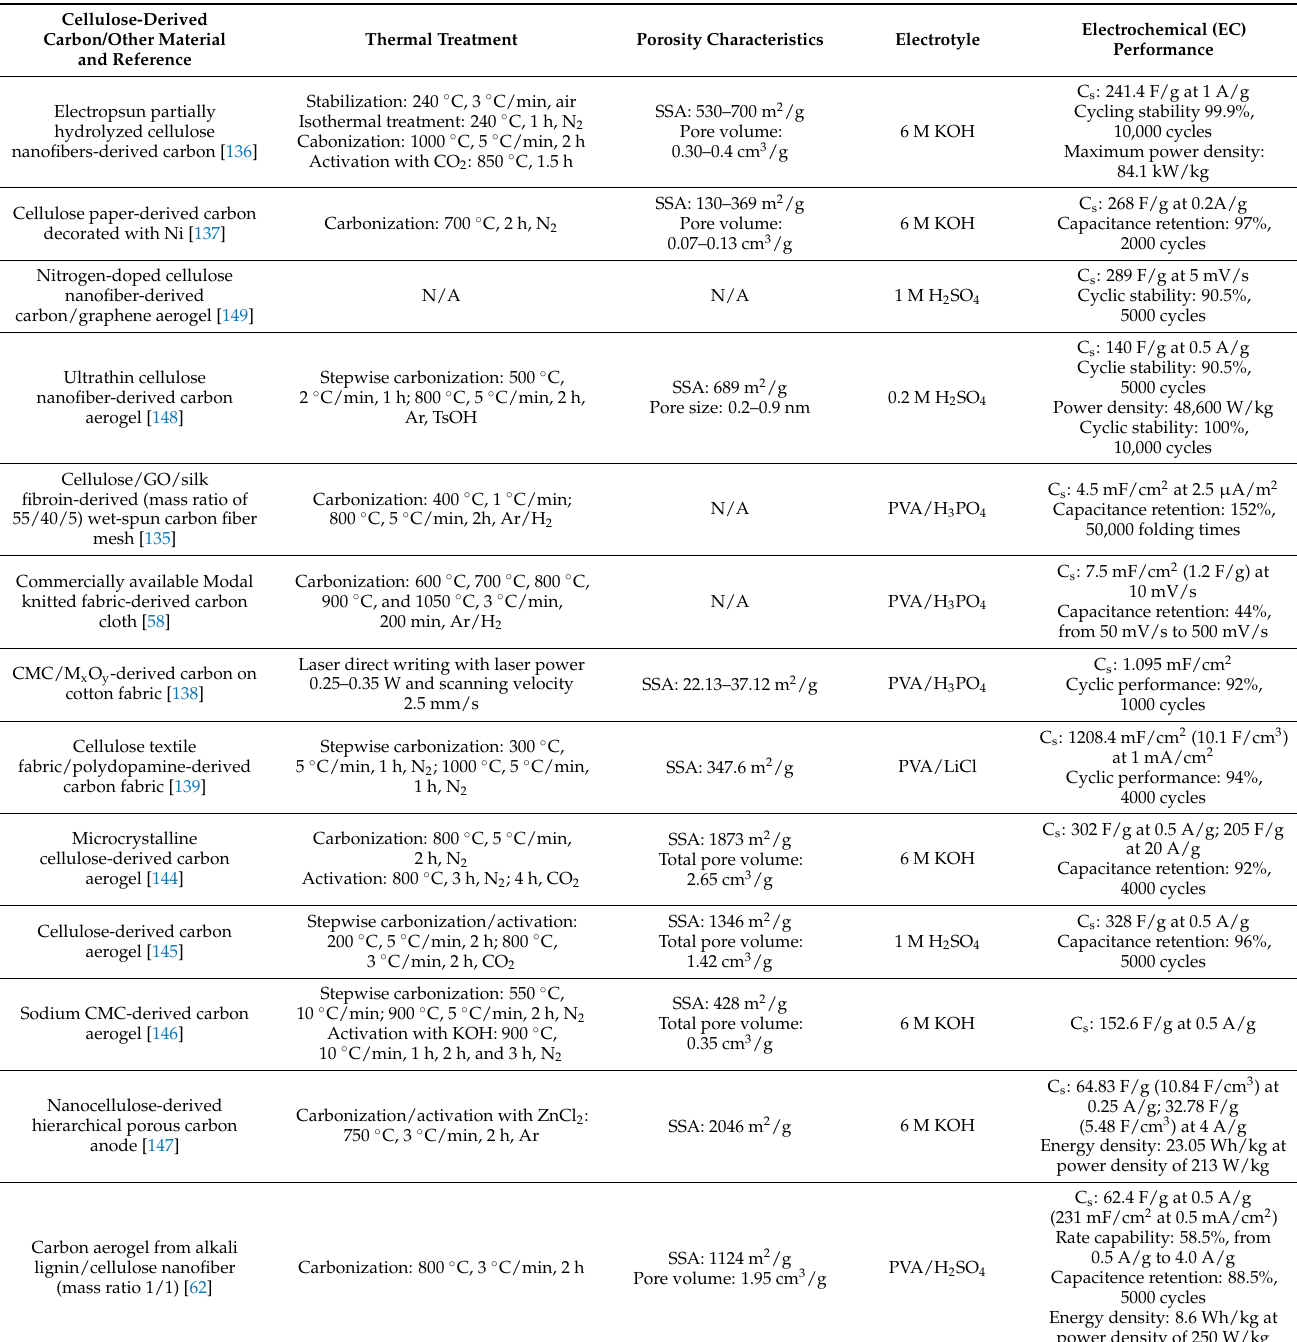
Table 3. Literature summary of cellulose-based carbon for flexible